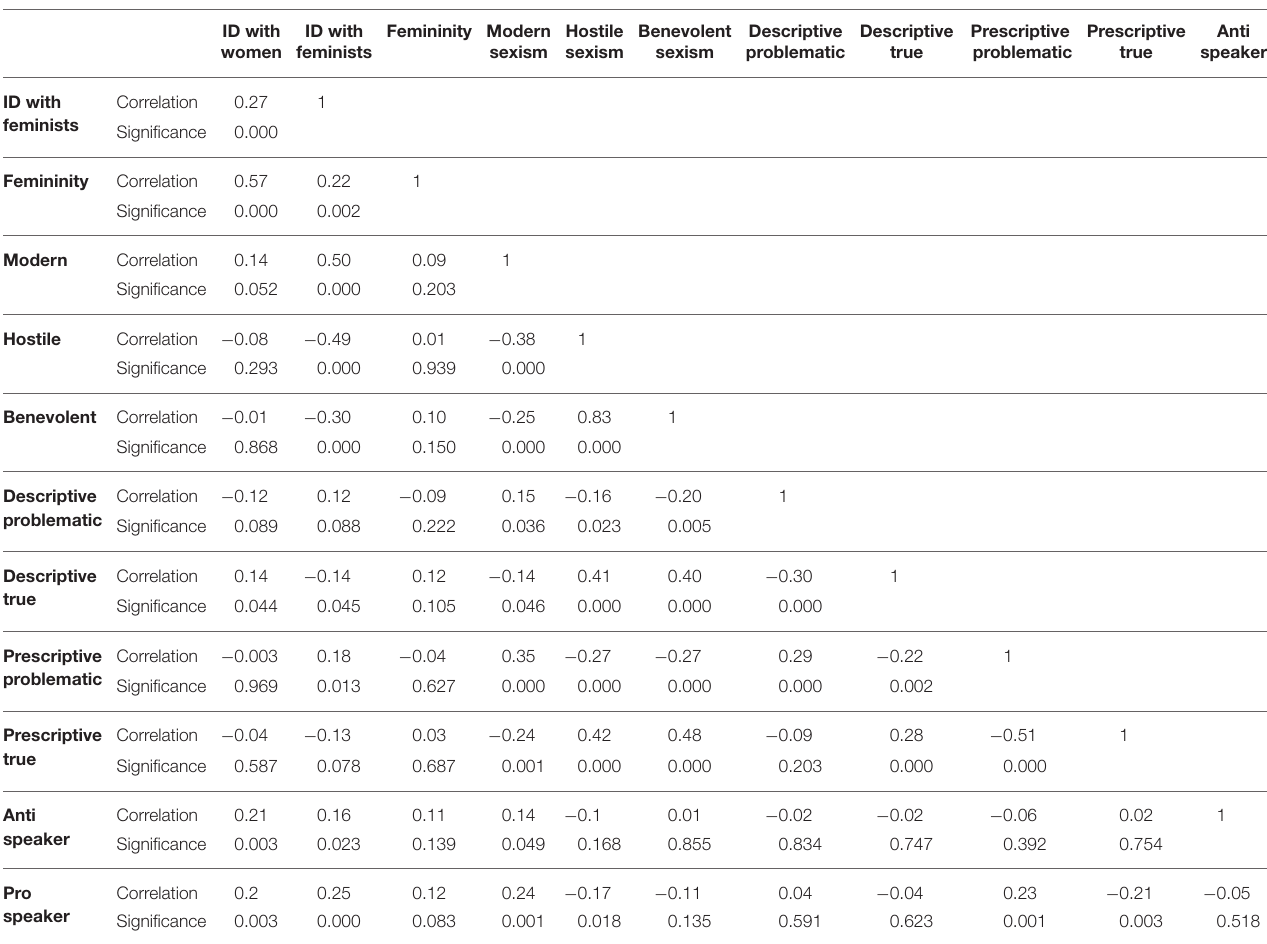
TABLE 6 | Correlation table for Study 4. ID with ID with Femininity Modern Hostile Benevolent Descriptive Descriptive Prescriptive Prescriptive Anti women feminists sexism sexism